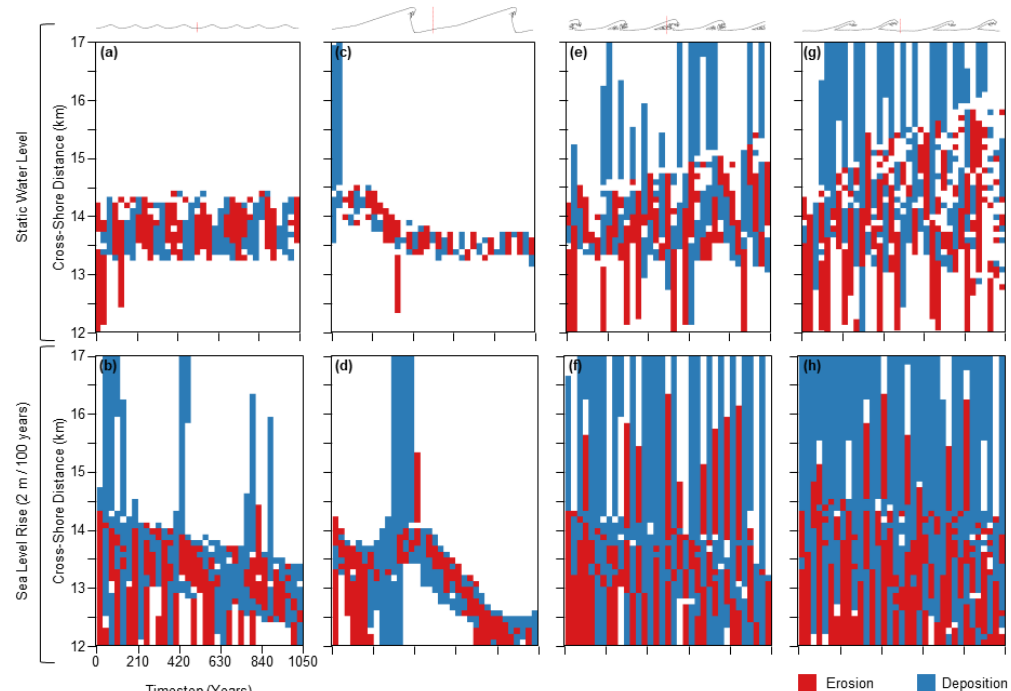
Figure 17. Volume stacks for four wave climate conditions defined by (a, b) A = 0.5 and U = 0.55, (c, d) A = 0.6 and U = 0.6, (e, f) A = 0.7 and U = 0.65, and (g, h) A = 0.8 and U = 0.7. Results with a static water level are shown along the top row (a, c, e, g) , and those with sea level rise at a rate of 2m/100yr are shown along the bottom row (b, d, f, h) . The shoreline outlines at the top of the figure are taken from the static water level scenarios, and the red line marks the cross-shore transect where the change in volume at 30-year time intervals is recorded.